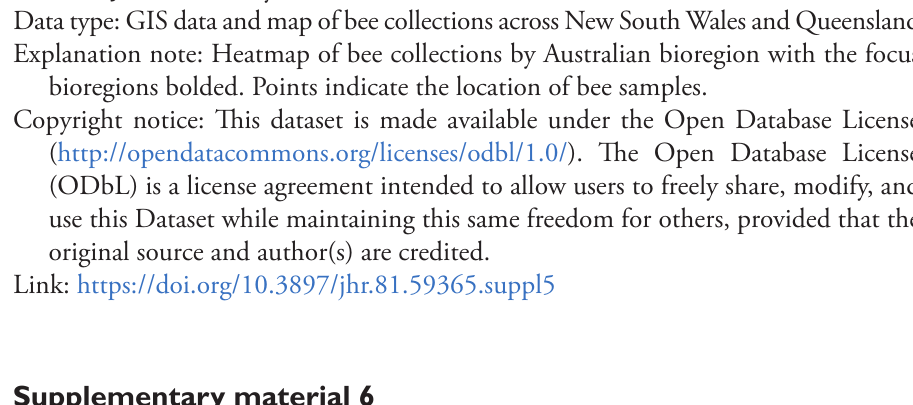
Data type: Results of collection bias